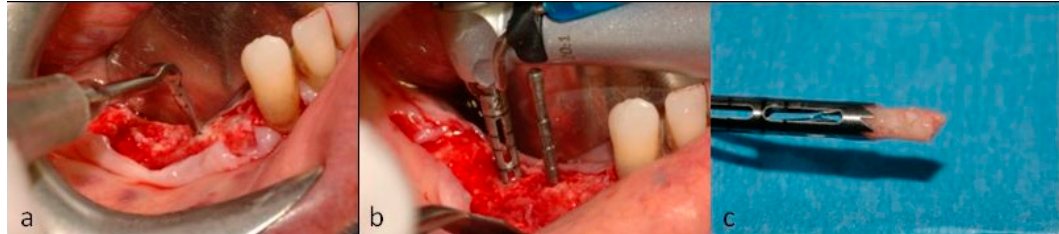
Figure 10. ( a ) Piezosurgery was used to prepare position 4.4 for implant placement. ( b ) The other two tunnels were drilled, and bone biopsies ( c ) were collected with a trephine.